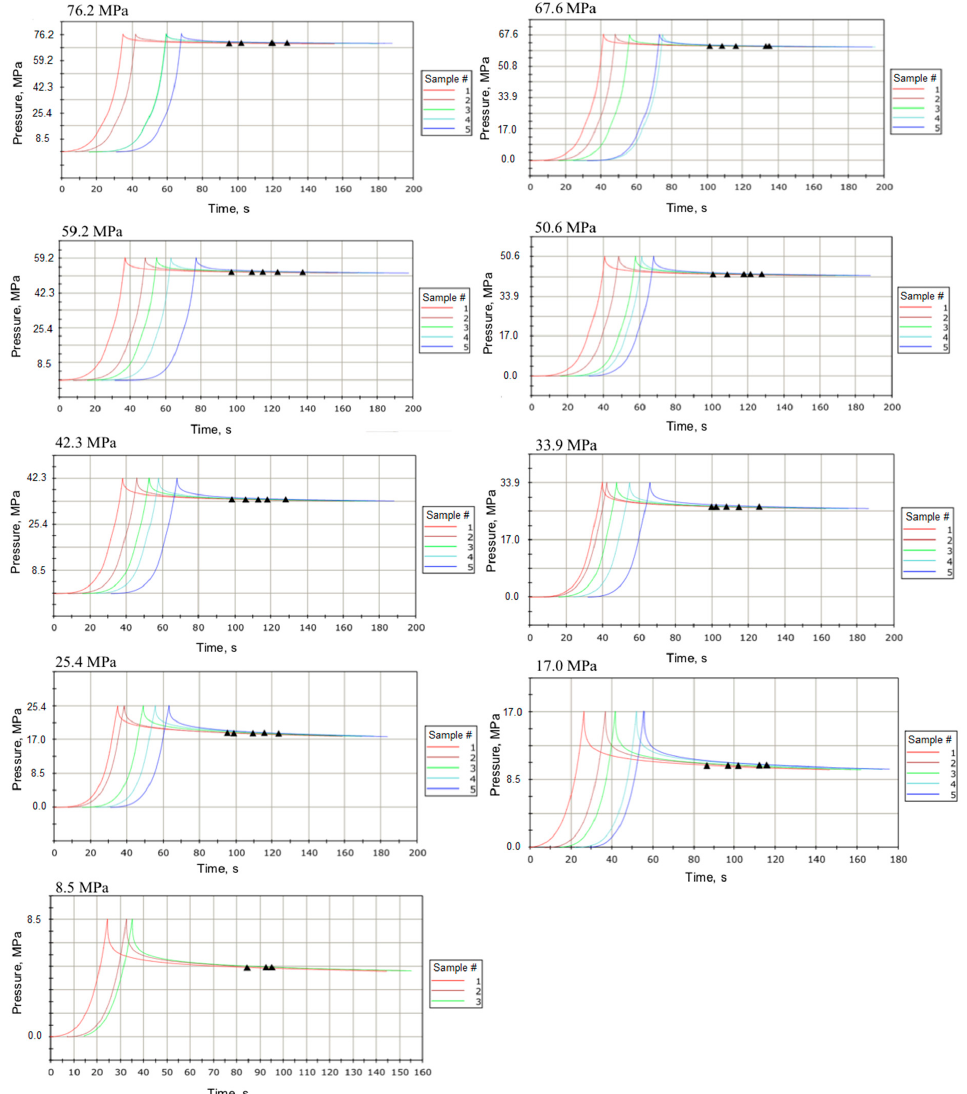
Figure A3. The densification (pelletization) of carbonized refuse-derived fuel (CRDF) with applied pressure varying from 8.5 MPa to 76.2 MPa.